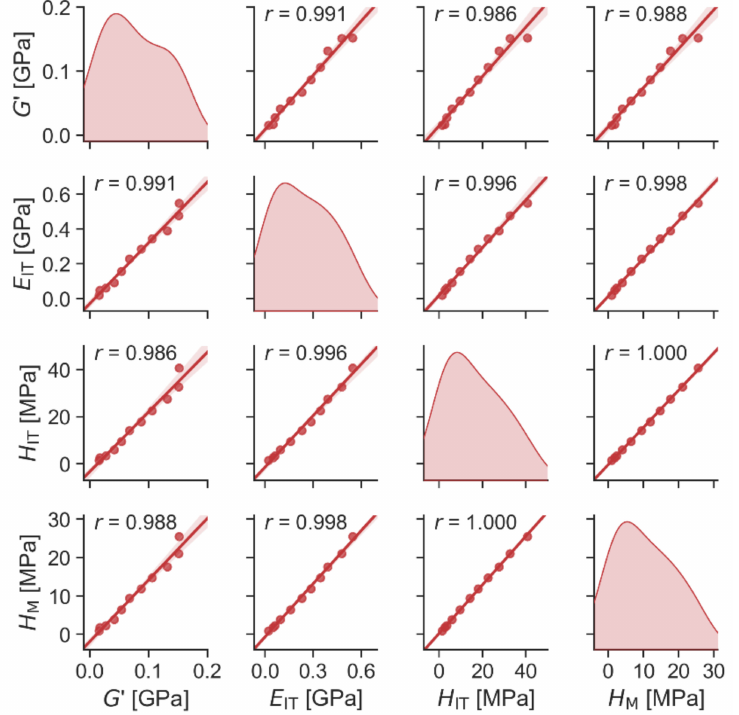
Figure 8. Scatterplot matrix graph showing correlation between selected micromechanical ( G (cid:48) ) and micromechanical properties ( E IT , H IT and H M ). Diagonal elements of the scatterplot matrix graph show distribution of the measured quantities, whereas off-diagonal elements show correlations between each pair of quantities. The translucent bands around the regression lines represent 95% confidence interval of the regression estimate. Moreover, all off-diagonal plots show the values of Pearson’s correlation coefficient r in the upper right